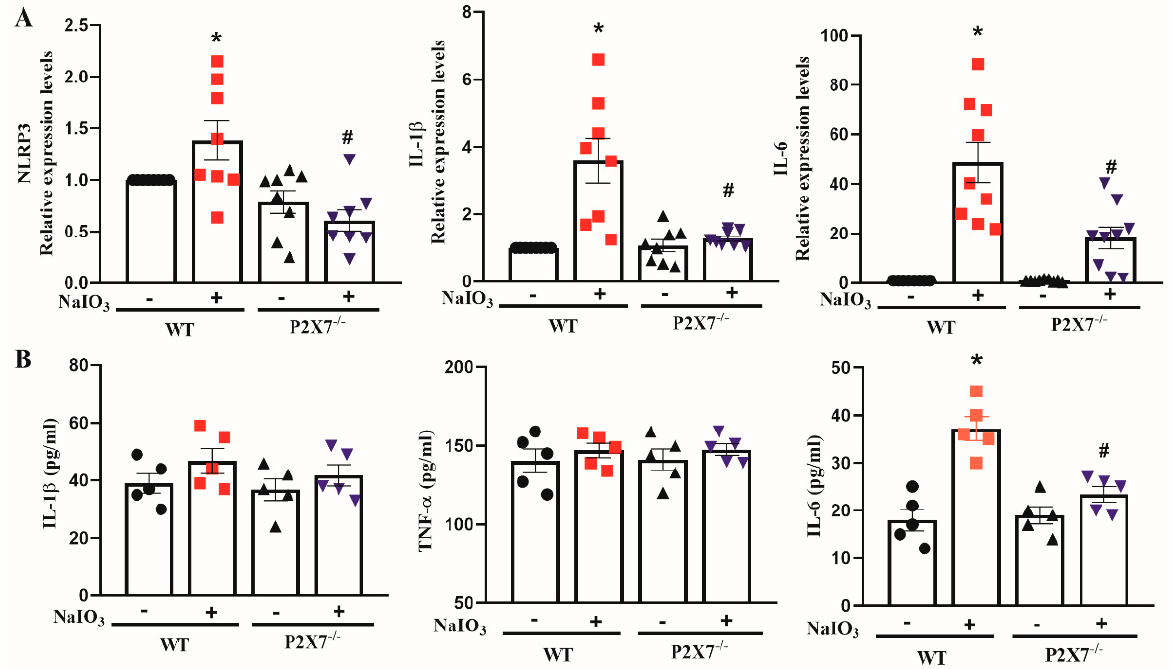
Figure 5. NaIO 3 -induced neuroinflammation in retina was reversed by P2X7 knockout. After 36 h post-injection of NaIO 3 (25 mg/kg), mice retina was collected. ( A ) Total mRNA was extracted and reversely transcribed for quantitative PCR analysis of NLRP3, IL-1 β and IL-6 mRNA expression. The mice number for qPCR analysis was 8 for each group. Values were normalized to β -actin gene expression and were expressed relative to the control group. ( B ) Parallelly, serum from mice was collected and subjected to ELISA to determine the amounts of IL-1 β , TNF- α and IL-6, respectively. The mice number for ELISA was 5 for each group. The data were presented as the mean ± SEM. * p < 0.05 compared with the WT control group, # p < 0.05 compared with the WT control group treated with NaIO 3 . 3.3. P2X7 Knockout Reduces Executional Caspases Expression in Retinal Tissues after NaIO 3 In- jection without Affecting NADP/NADPH NaIO 3 -induced oxidative stress and caspase activation are involved in RPE/photore- ceptor damage [28,30,32]. So, we were interested in understanding the caspase expression and oxidative stress upon NaIO 3 -induced retinal degeneration. We found that NaIO 3 can significantly trigger caspase-3, -7 and -8 gene expressions in WT mice. In contrast, such caspases upregulation was significantly reduced in P2X7 − / − mice (Figure 6A). For oxidative stress, we found that NaIO 3 did not change the cellular levels of total NADP, NADPH and ratio of NADP/NADPH in the retinal tissues of WT mice. The contents of these molecules were neither changed in P2X7 − / − mice (Figure 6B).